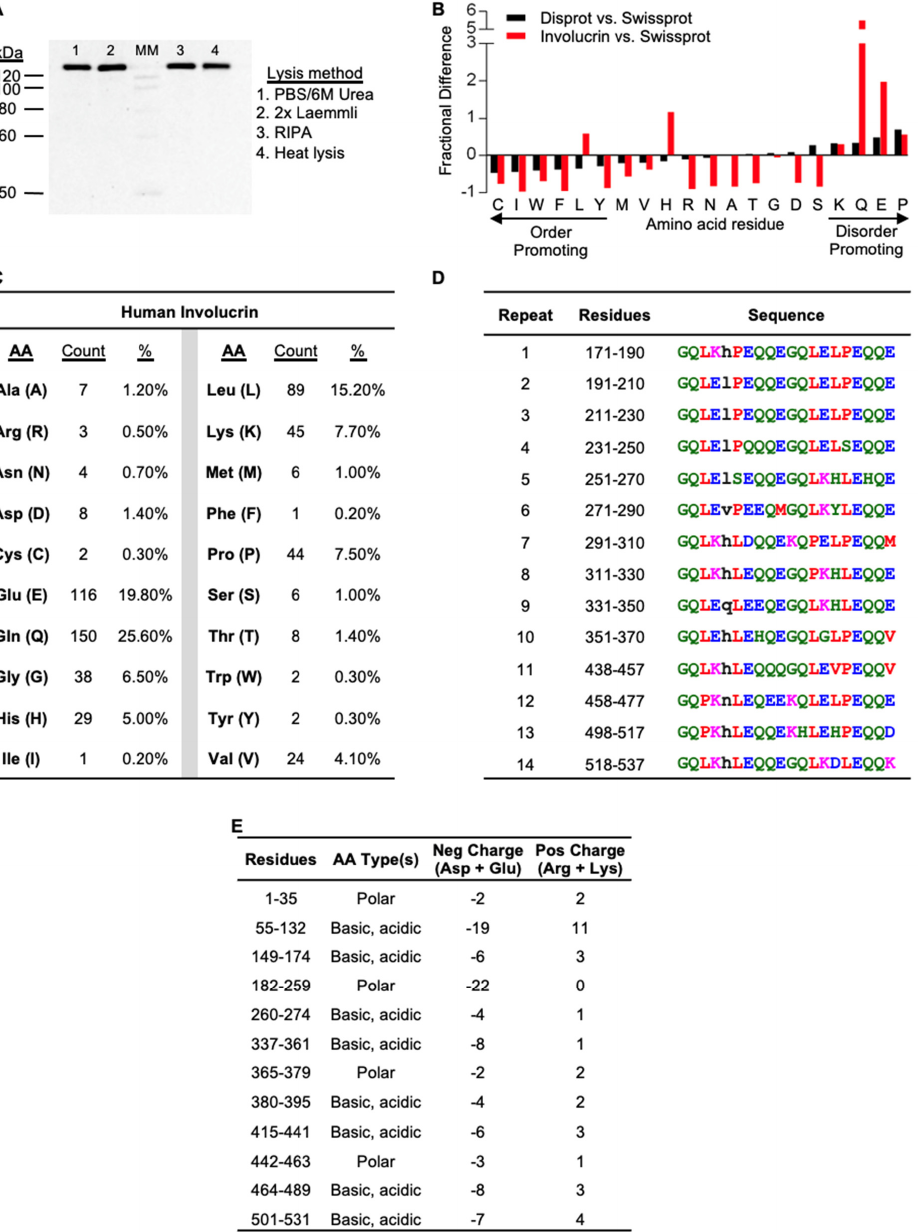
Figure 1. Involucrin enrichment in a thermostable protein extract and computational analysis indicate IDP characteristics. ( A ) Involucrin preferential recovery in a heat lysate; 240 ng protein per lanes 1–3, 50 ng protein lane 4. MM, MagicMark western standards. ( B ) Involucrin compositional bias compared against SwissProt ordered proteins. Note break in y-axis for Q (glutamine, Gln). ( C ) Amino acid (AA) counts and percentages for 585AA full-length human involucrin. ( D ) RADAR Repeat detection. AA color indicates shared properties. A V F P M I L W: red, small and hydrophobic; D E: blue, acidic; R K: magenta, basic; S T Y H C N G Q: green, hydroxyl, sulfhydryl, or amine. Lower case black letter AA are considered unaligned. ( E ) Regional AA enrichment.